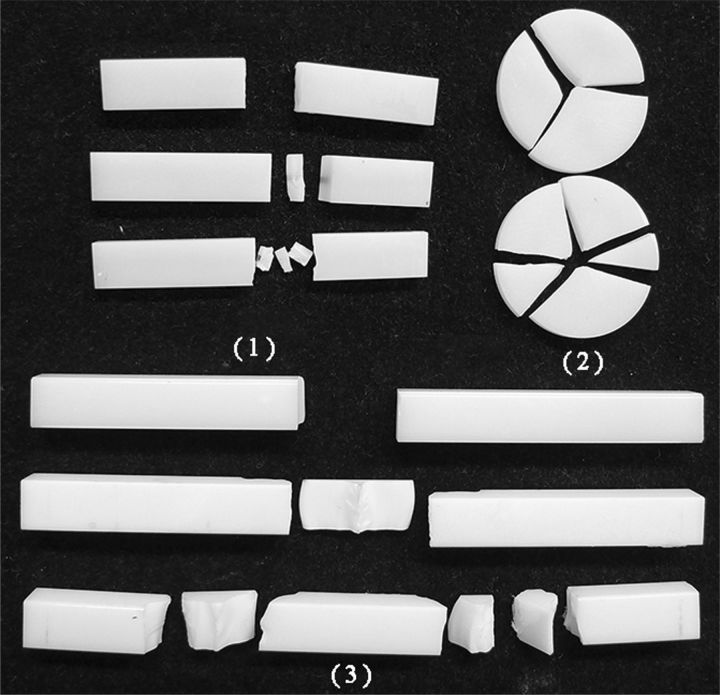
The examples of fracture morphology of ceramics tested by (1) 3PF-s, (2) BI and (3) 4PF. There was Group I, Group II and Group III from top to bottom for each method.